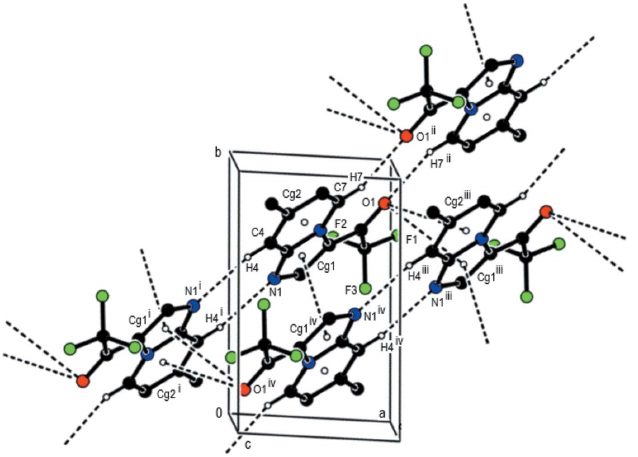
Figure 2 A general view of the C—H (cid:2)(cid:2)(cid:2) O and C—H (cid:2)(cid:2)(cid:2) N hydrogen bonds and (cid:2) – (cid:2) stacking interactions in the title compound, depicted by dashed lines. Hydrogen atoms not involved in hydrogen bonding are omitted. [Symmetry codes: (i) (cid:4) x , (cid:4) y + 1, (cid:4) z + 1; (ii) (cid:4) x + 2, (cid:4) y + 2, (cid:4) z + 1; (iii) x + 1, y , z ; (iv) (cid:4) 1 + x , y , z .]